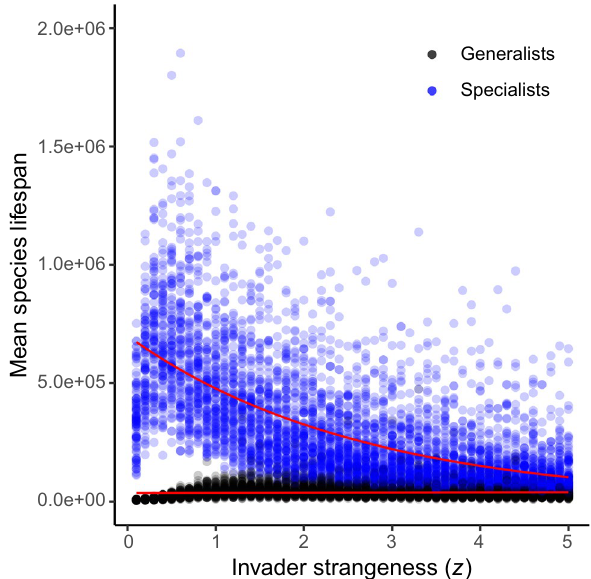
Figure 5. Relative persistence of generalists and specialists. Shows the mean lifespan of all species per simulation across the invader strangeness ( z ) sweep. Species are binned into “generalist” ( s ≥ 0.39) and “specialist” ( s ≤ 0.32) categories given their feeding range ( s ) trait values. Curves (in red) are fit using a generalized linear model with a Poisson error distribution and log link function. 95% confidence intervals for the figure were too narrow to